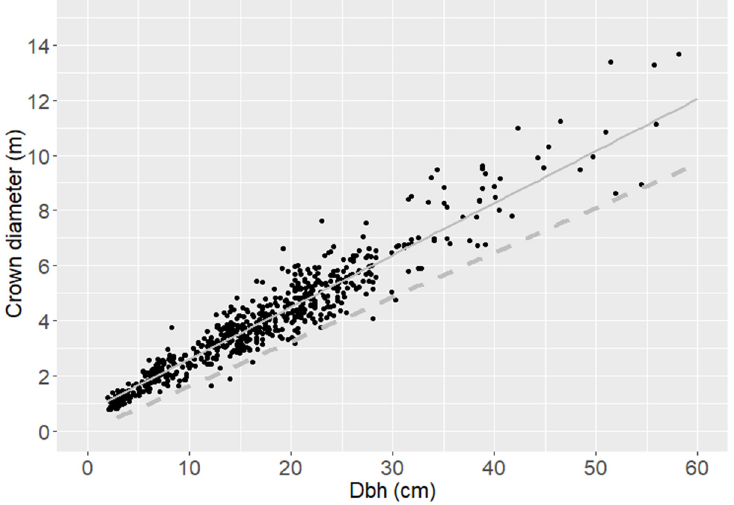
Figure 4. Scatterplot between tree dbh and crown diameter. The modeled relationship is shown by the solid gray line (Equation (1)). The relationships fitted by Hemery et al. [38] is shown by the dashed gray line.